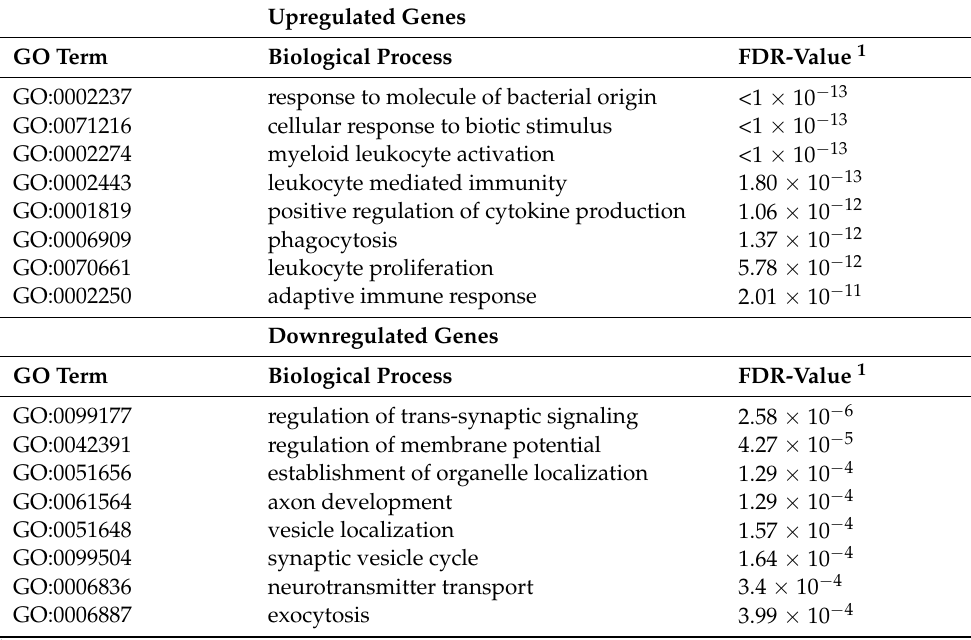
Table 1. Enriched biological processes (Gene Ontology-GO) of DEGs found.